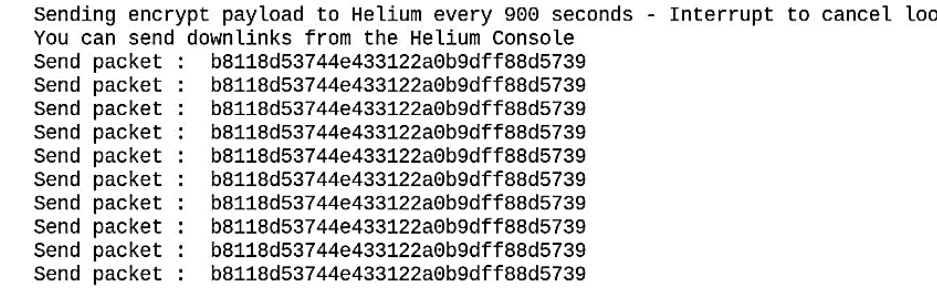
Figure 22. Node sending encrypted data.